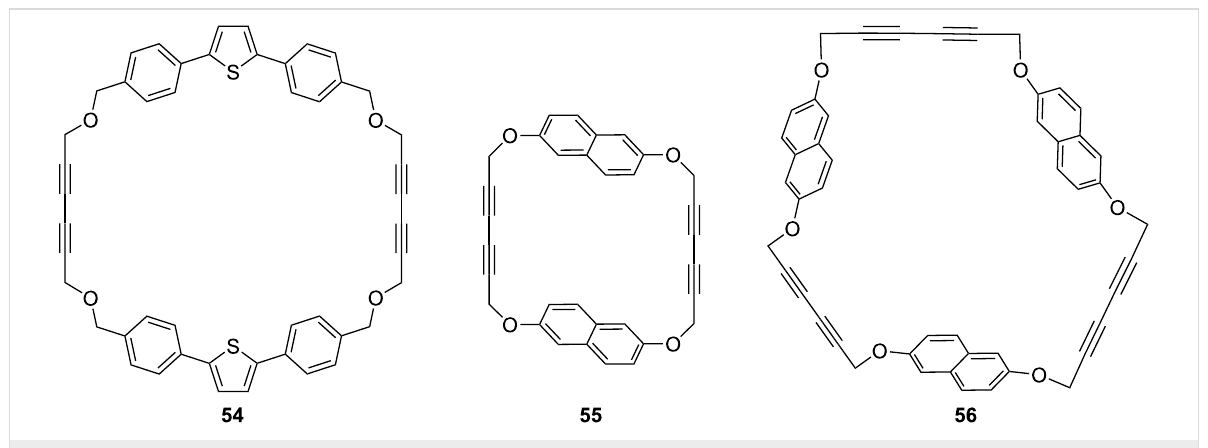
Figure 6: Cyclophanes 54–56 that have been synthesized through Glaser–Eglinton